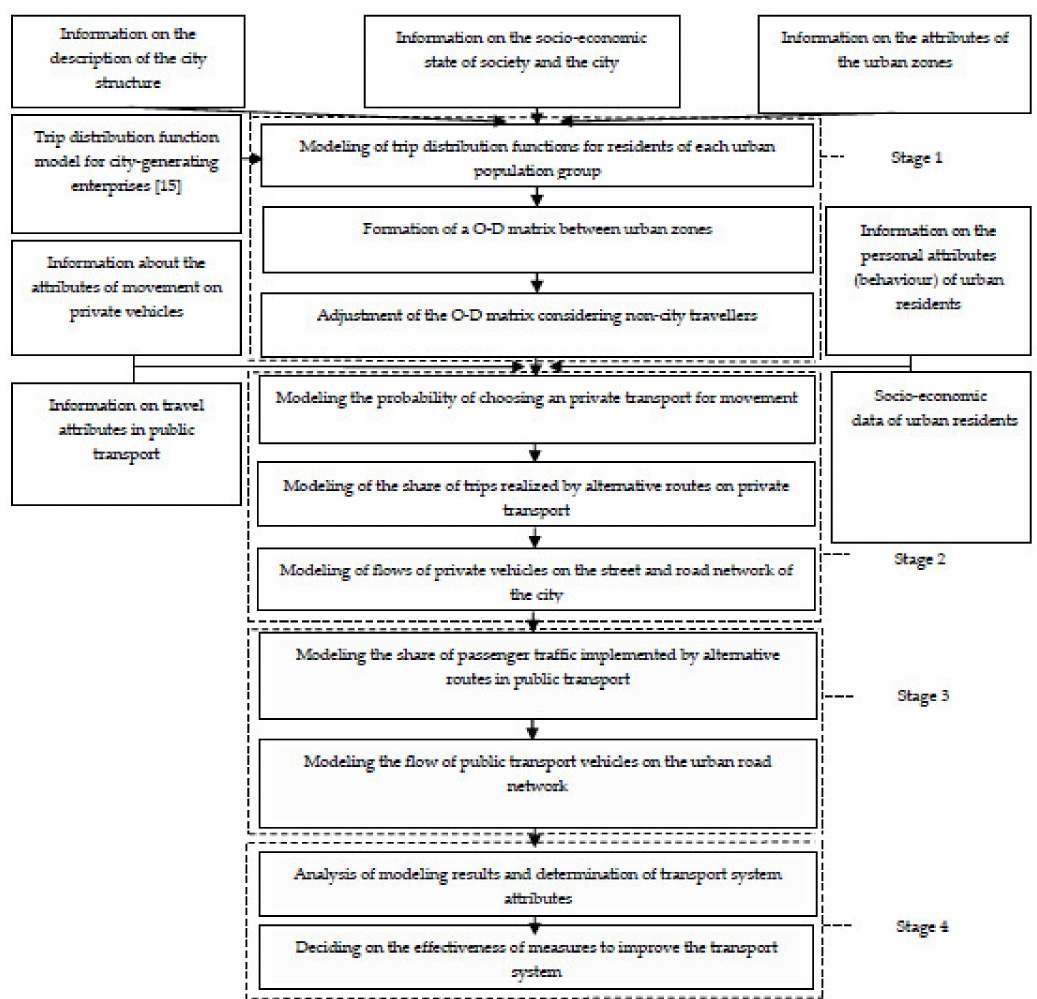
Figure 3. Sequence of stages of modeling transport and passenger flows in human-centric urban transport